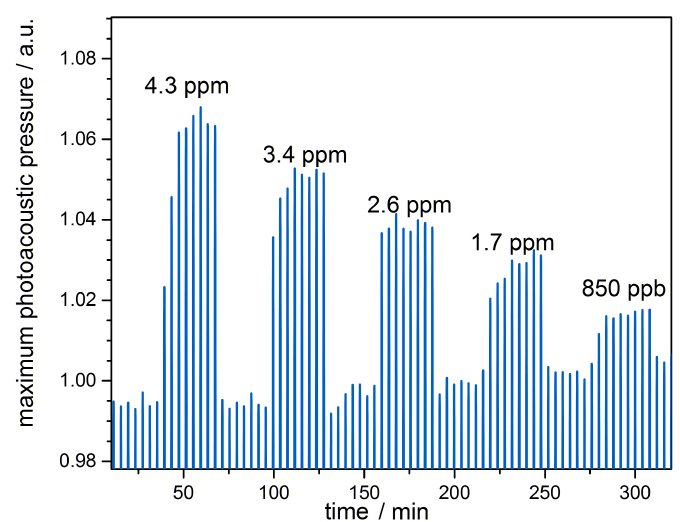
Figure A1. Measurement with the same setup but with a H-cell similar to the work of El-Safoury et al. [14]. The H-cell has a resonator length of 40 mm and a diameter of 3 mm. The buffer volumina have both a diameter and a length of 20 mm. In this setup, the offset is equivalent to 65.4 ppm NO 2 . Due to the high offset, the zero gas signal is more vulnerable to drift effects and therefore less